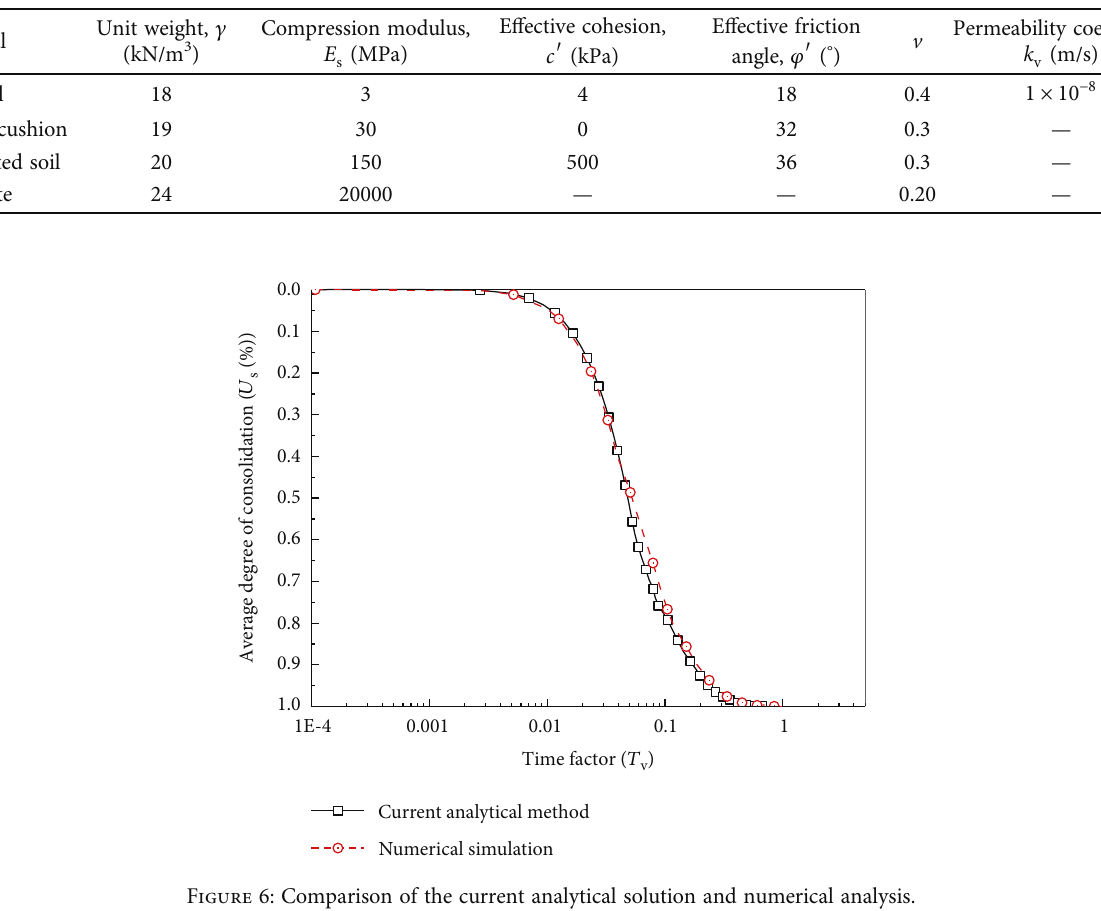
on the consolidation 1